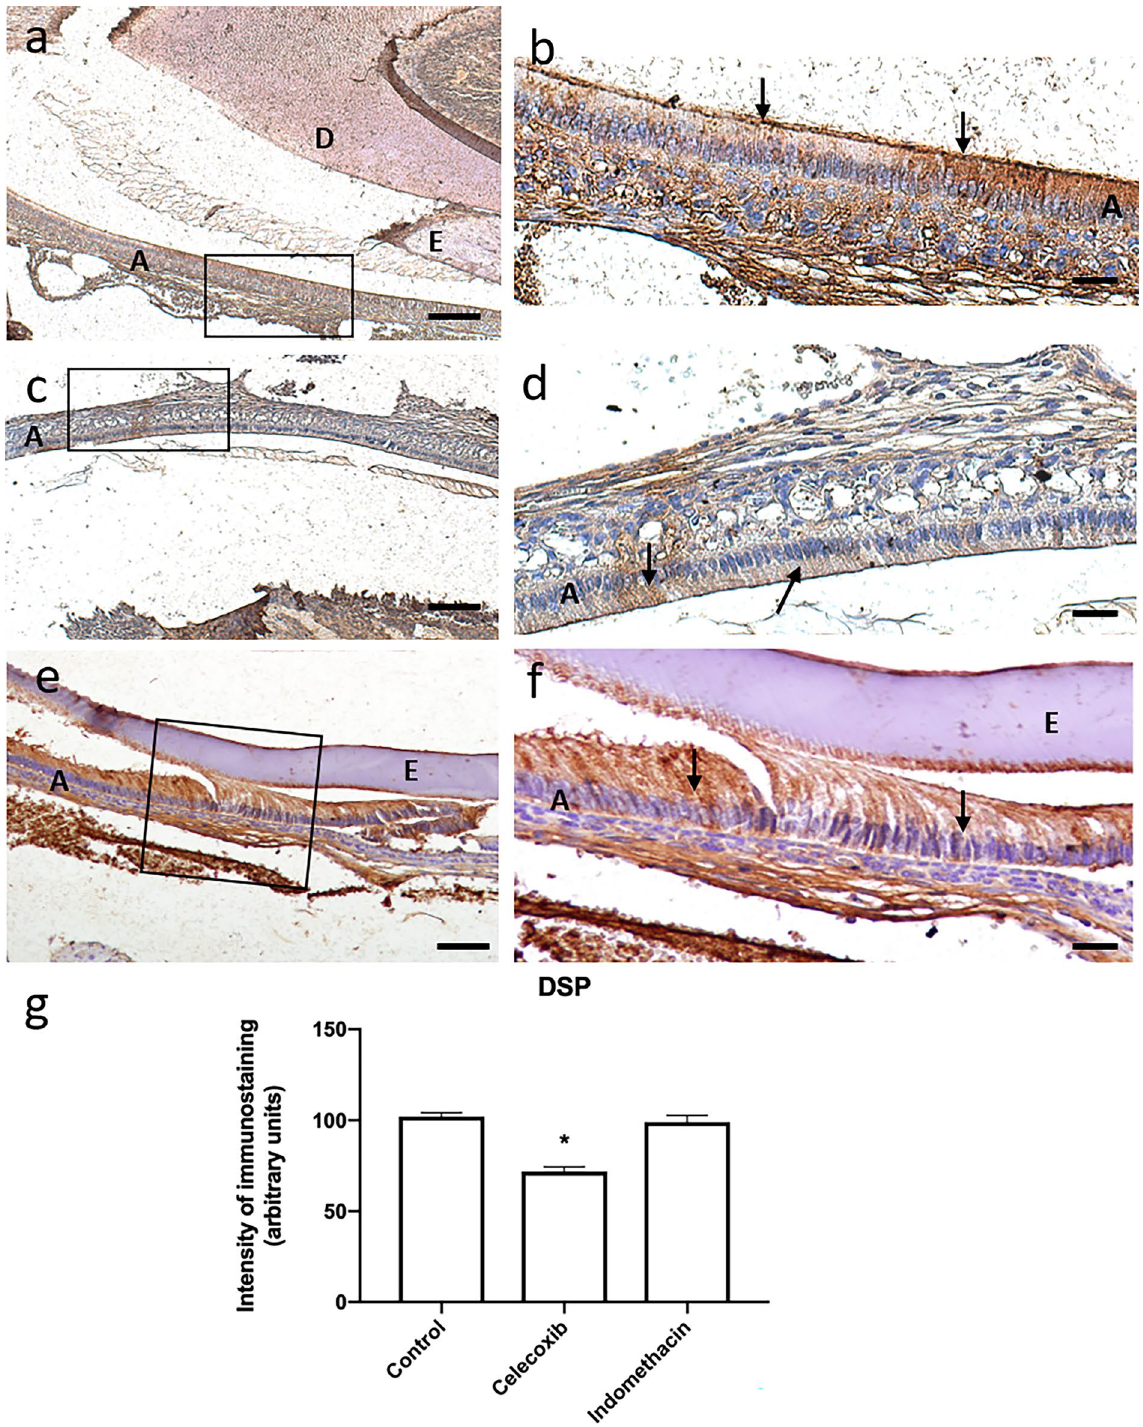
Figure 8. Control group (n = 20) shows intense DSP immunoreactivity (10× / scale = 100 µm) ( a ), (20× / scale = 50 µm) ( b ). Group treated with Celecoxib (n = 20) showed mild inhibition of DSP protein compared to control (10× / scale = 100 µm) ( c ), (20× / scale = 50 µm) ( d ), while Indomethacin-treated group (n = 20) showed more intense expression than celecoxib-treated group (n = 20) (20× / scale = 50 µm) ( e ), (20× / scale = 50 µm) ( f ). Graphical representation of immunostaining quantification of DSP protein synthesis using image deconvolution- median and interquartile range ( g ). A: ameloblasts, E: enamel layer, D: dentin